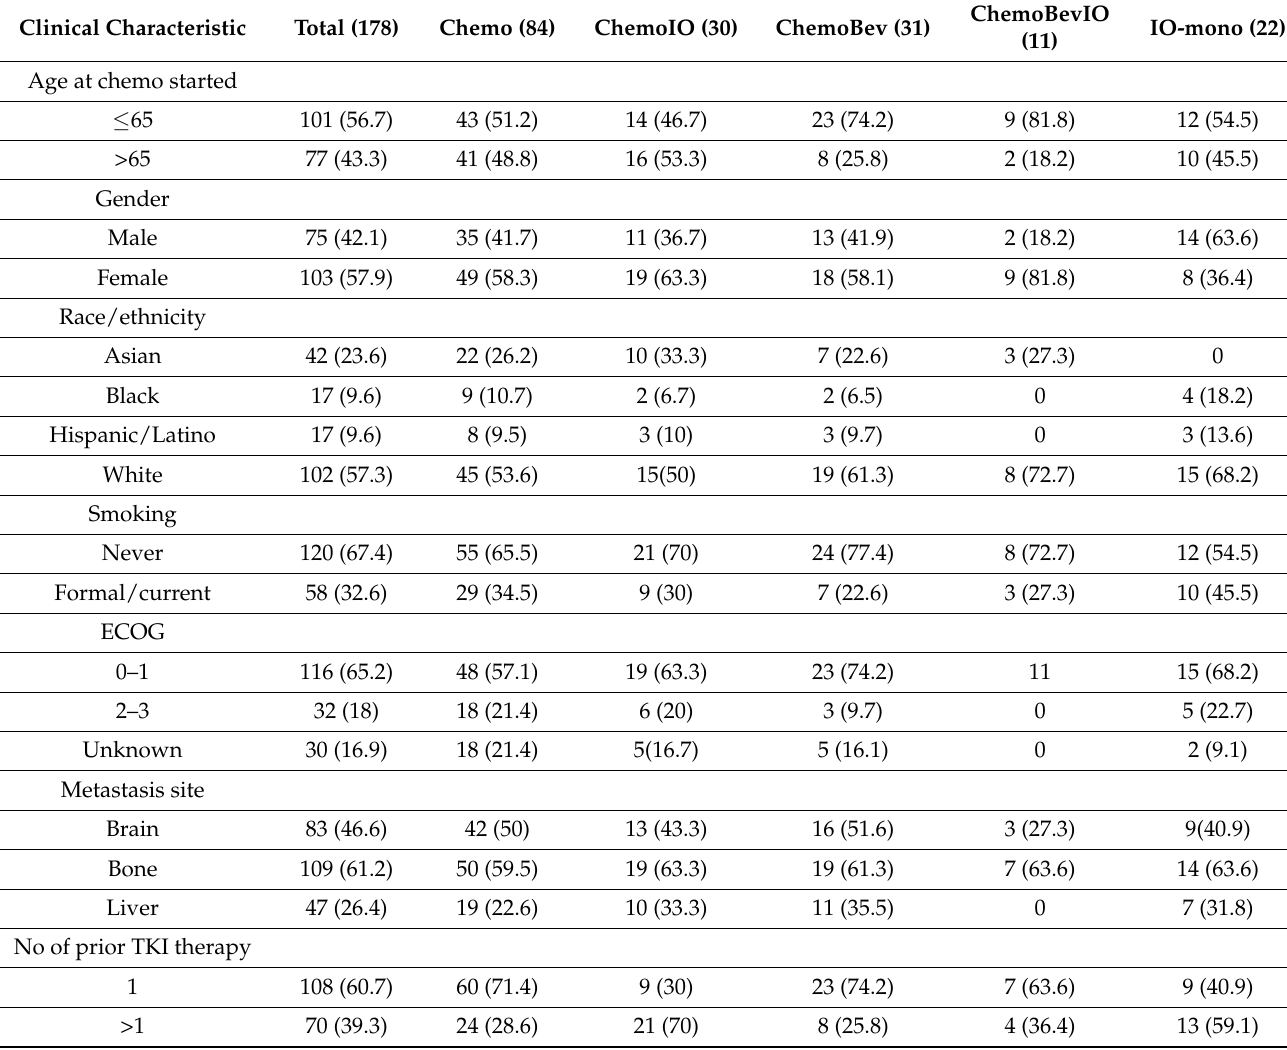
Table 1. Characteristics of EGFR-mutant lung adenocarcinoma patients treated with non-TKI systemic therapy after TKI ( n =